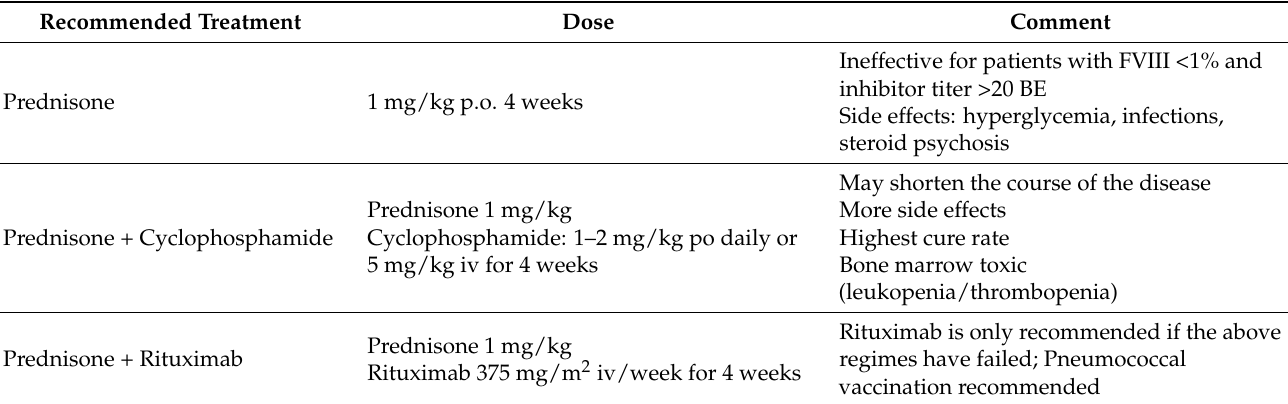
Table 2. Drugs for eradication; modified according to Kruse-Jarres